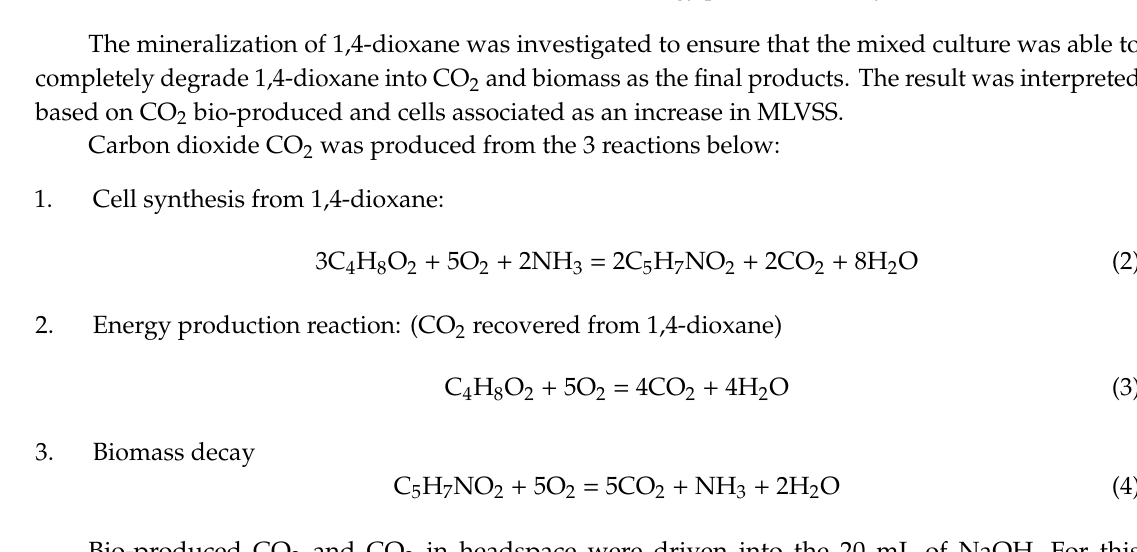
Figure 2. Utilization of electron donor for energy production and synthesis.